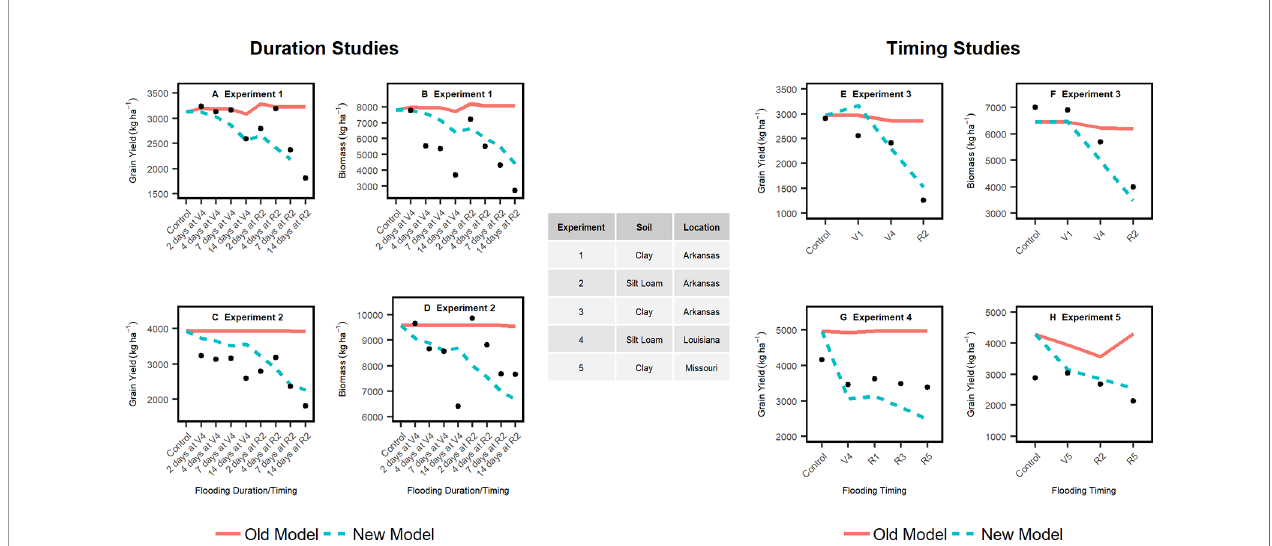
FIGURE 4 | Simulated grain yield and biomass with the improved and original APSIM model (lines) versus experimental data ( fi lled cycles) from fl ooding duration (left panels) and fl ooding timing (right panel) studies. The fl ooding events for the duration studies (A – D) were initiated at V4 (4 th leaf) and R2 (early reproductive stage). The fl ooding events for the timing studies (E – H) were initiated at V4 (4 th leaf), R1 (Beginning of reproductive phase), R3 (beginning of pod fi lling period), and R5 (end of pod fi lling period).